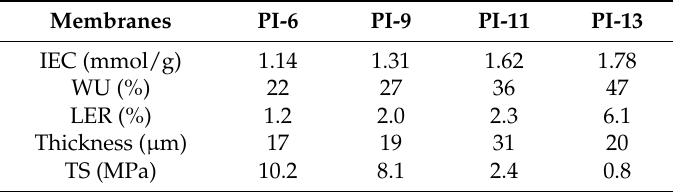
Table 2. Ion exchange capacity (IEC), water uptake (WU), linear expansion ratio (LER), thickness and tensile strength of AEMs with increasing amounts of